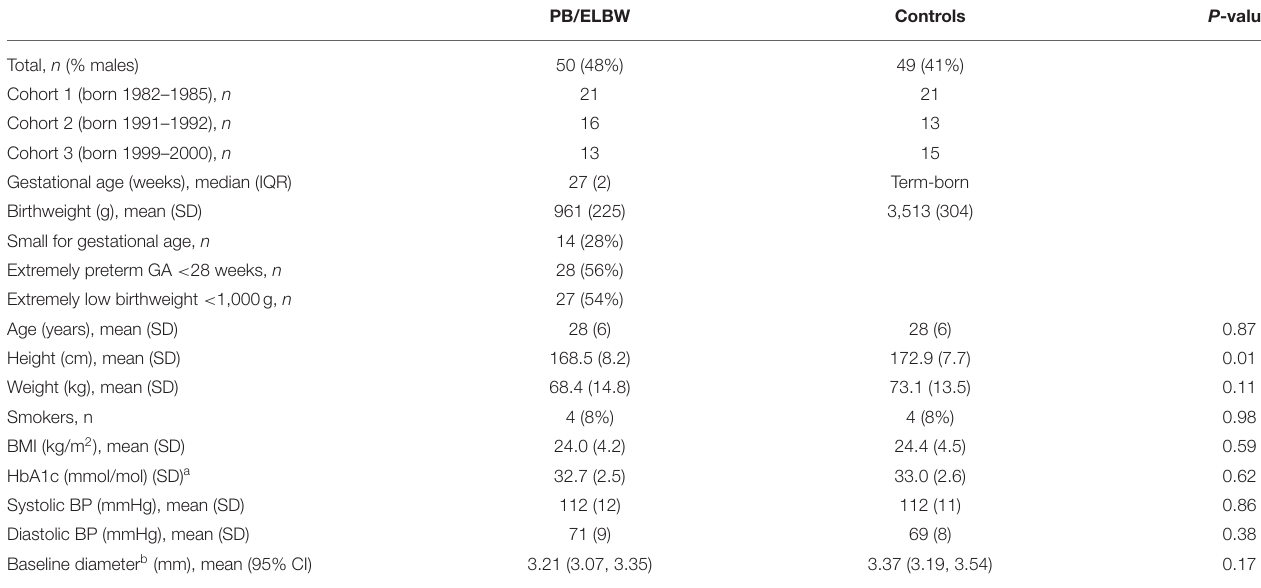
TABLE 1 | Characteristics of study